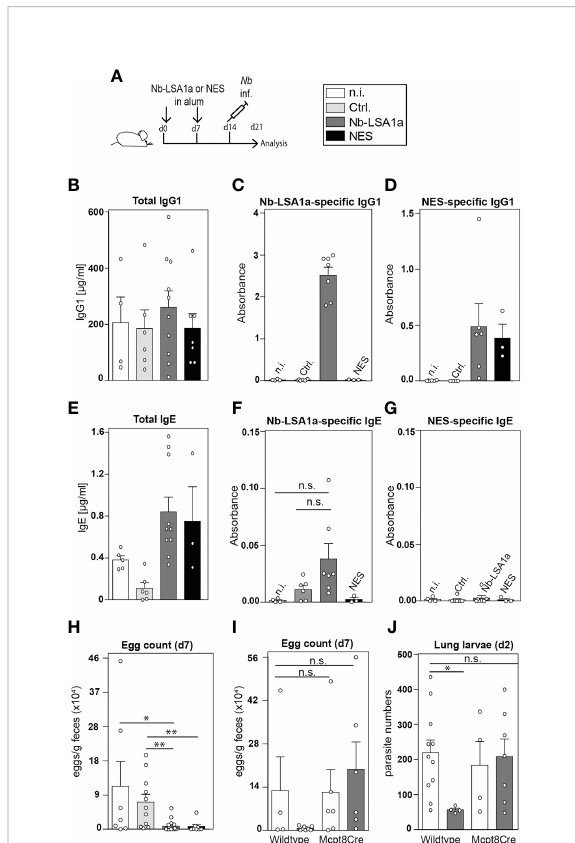
FIGURE 4 Basophil-mediated protection in Nb-LSA1a immunized mice. (A) Experimental setup. Mice were immunized with 1-10 µg protein (NES, Nb-LSA1a or Ctrl) in alum i.p. on day 0 and 7, infected with Nb on day 14 and analyzed on day 21. (B – D) Total (B) , Nb-LSA1a-speci fi c (C) , and NES-speci fi c (D) serum IgG1 levels of wild-type mice which had not been immunized (n.i., white bar), or immunized with supernatant of HEK293T cells transfected either with an empty vector (Ctrl., light gray bar) or Nb-LSA1a vector (dark gray bar), or immunized with NES (black bar). (E – G) Total (E) , Nb-LSA1a-speci fi c (F) , and NES-speci fi c (G) serum IgE levels of wild-type mice, treated as described in B-D. Calculation of mouse serum concentrations for 4 to 10 samples and absorbance calculated for 4 to 7 samples per group. (H, I) Fecal egg counts on day 7 post Nb infection. (I) Immunization was carried out with puri fi cation buffer (white bars) or Nb-LSA1a puri fi ed protein (dark grey bar). (J) Number of larvae in the lung on day 2 post Nb infection of wild-type or